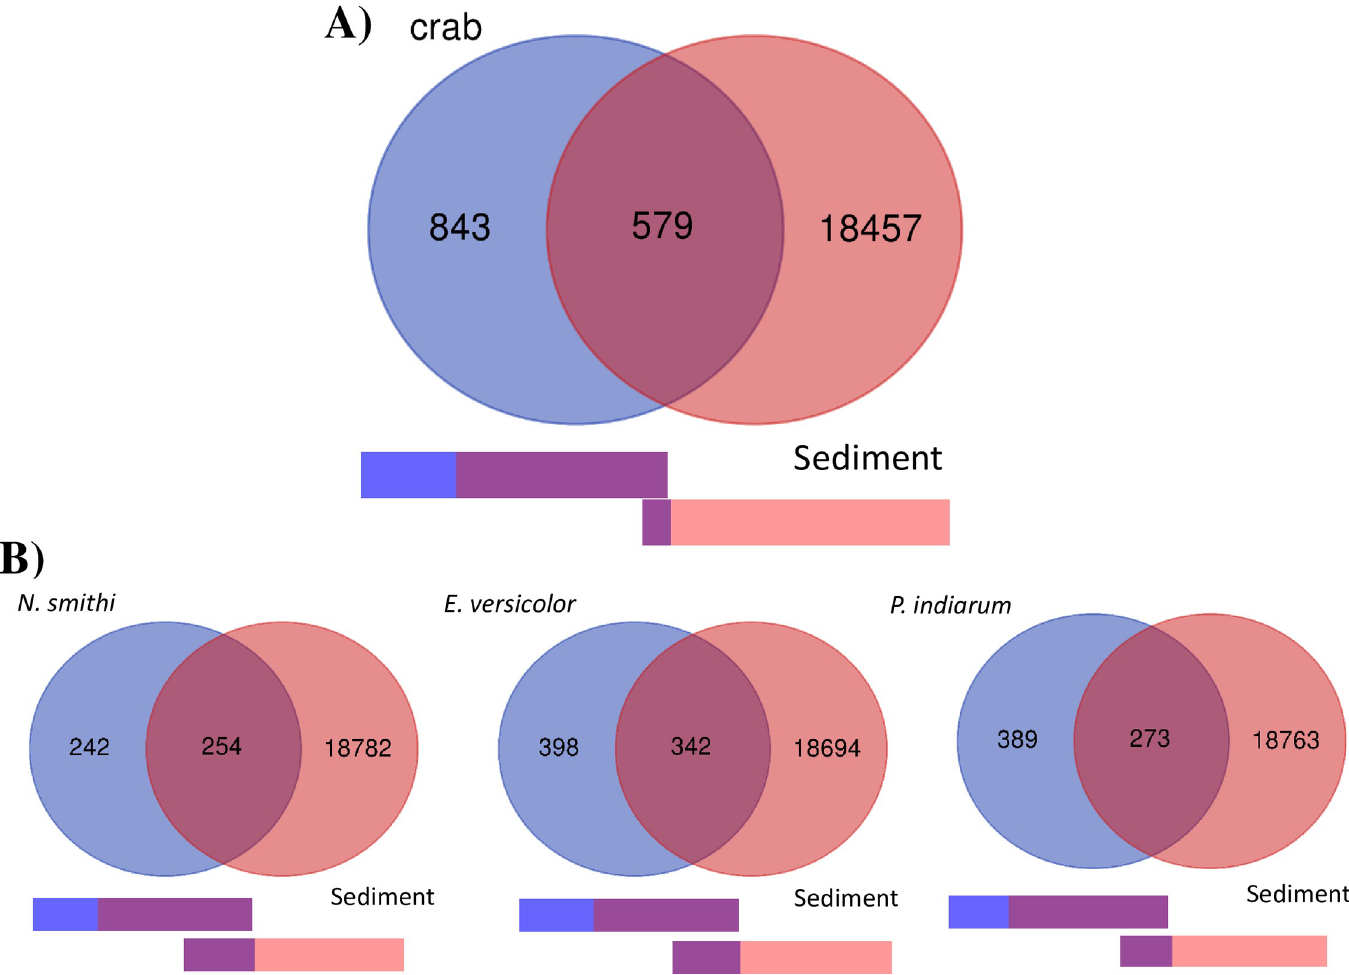
Fig 5. Venn diagram analysis of crab intestinal and sediment bacteria. A) Analysis of total OTUs between crab intestine and sediment samples. Bar below indicates the percentage of reads, and purple region represents the percentage of shared OTUs. B) Analysis between each of the crab species and total sediment OTUs. The shared OTUs are summarized in S7